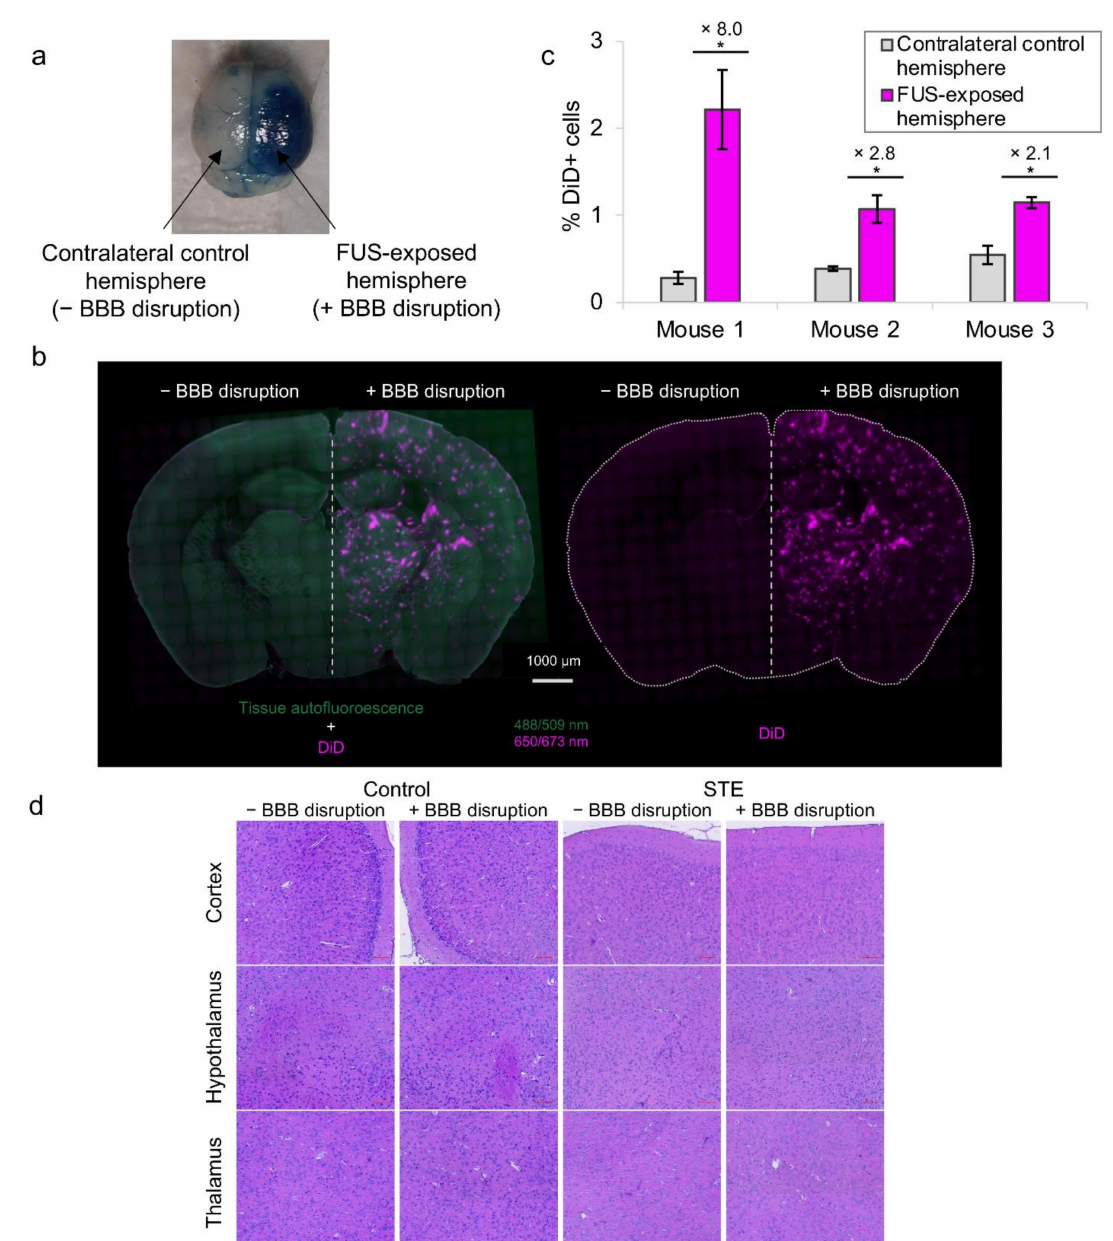
Figure 5. In vivo intracerebral accumulation of nanodroplets after BBB disruption. ( a ) Evans blue coloration on sonicated hemisphere after FUS exposure to 0.33 MPa acoustic pressure. ( b ) Fluores- cence microscopy imaging of coronal brain slices after retro-orbital i.v. administration with STE (pale blue-purple) and hemispheric FUS procedure application. ( c ) Fluorescence-activated cell-sorting analysis of DiD positive cells in sonicated and unsonicated (control) brain hemispheres after retro- orbital i.v. administration with STE and hemispheric FUS procedure application ( n = 3 areas for each hemisphere, * p < 0.05, Student’s t -test). ( d ) Histologic analysis of coronal brain slides of two hemispheres (sonicated and unsonicated) with hematoxylin–eosin staining after hemispheric FUS procedure application on one untreated mouse (control) and one mouse treated intravenously with STE. Scale bar = 100 µ